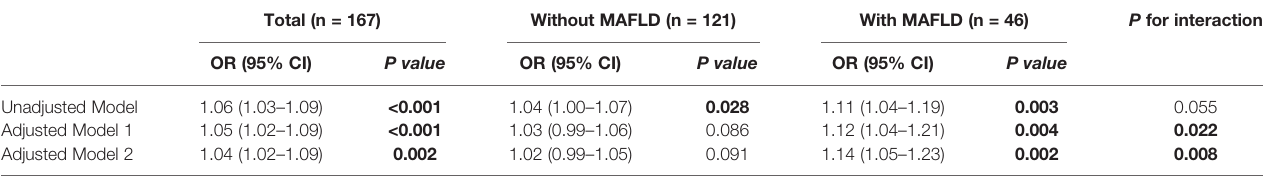
Data are expressed as odds ratio (OR) and 95% con fi dence intervals as tested by univariable (unadjusted) and multivariable (adjusted) logistic regression analysis. Adjusted Model 1: adjusted for age and sex Adjusted Model 2: adjusted for age, sex, overweight/obesity, type 2 diabetes, and hypertension. Bold values represent statistical signi fi cant P